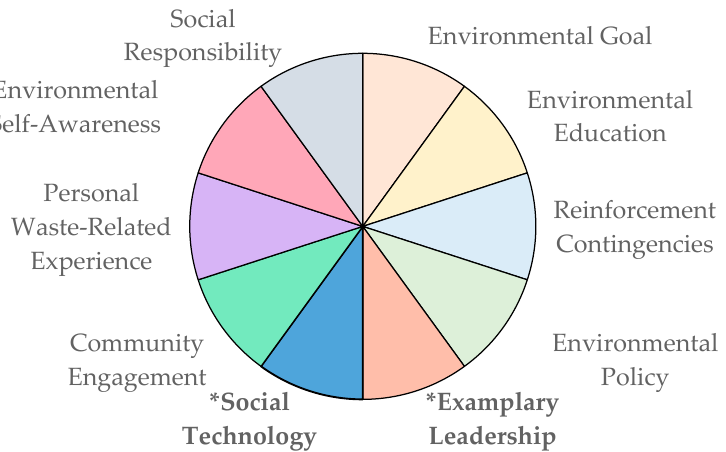
Figure 4. Relevant factors influencing USM’s community campus’ pro-environmental behaviour. * Bold text: Additional factors.